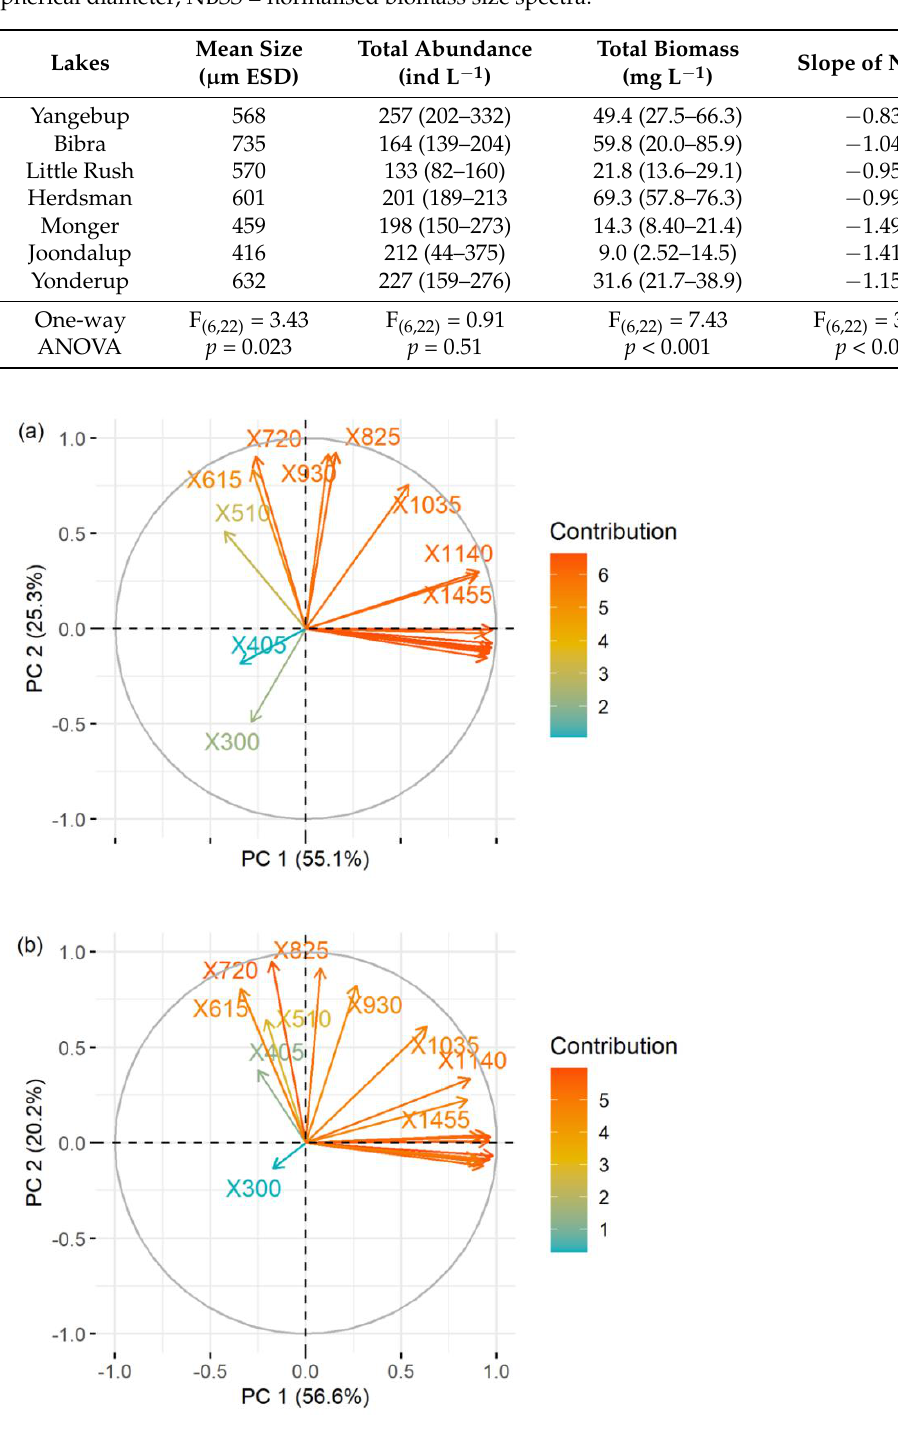
Figure 5. Mean body size averaged for each lake showing the average smallest and largest size from three to four sampling points at each lake; all sizes are in µm equivalent spherical diameter (ESD).